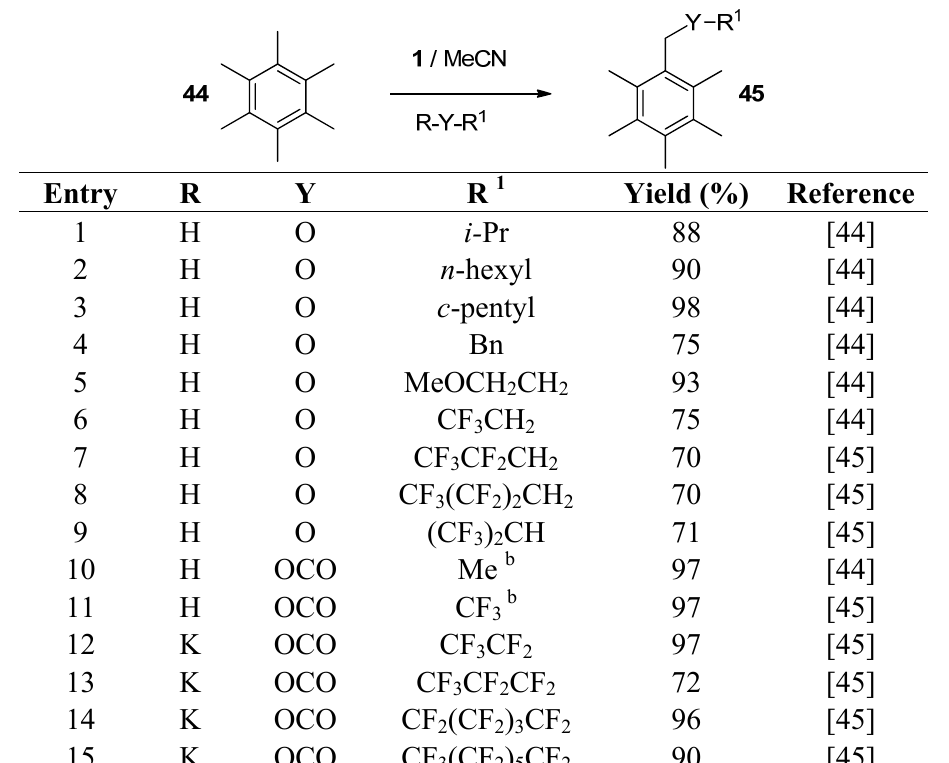
1 in the presence of 4